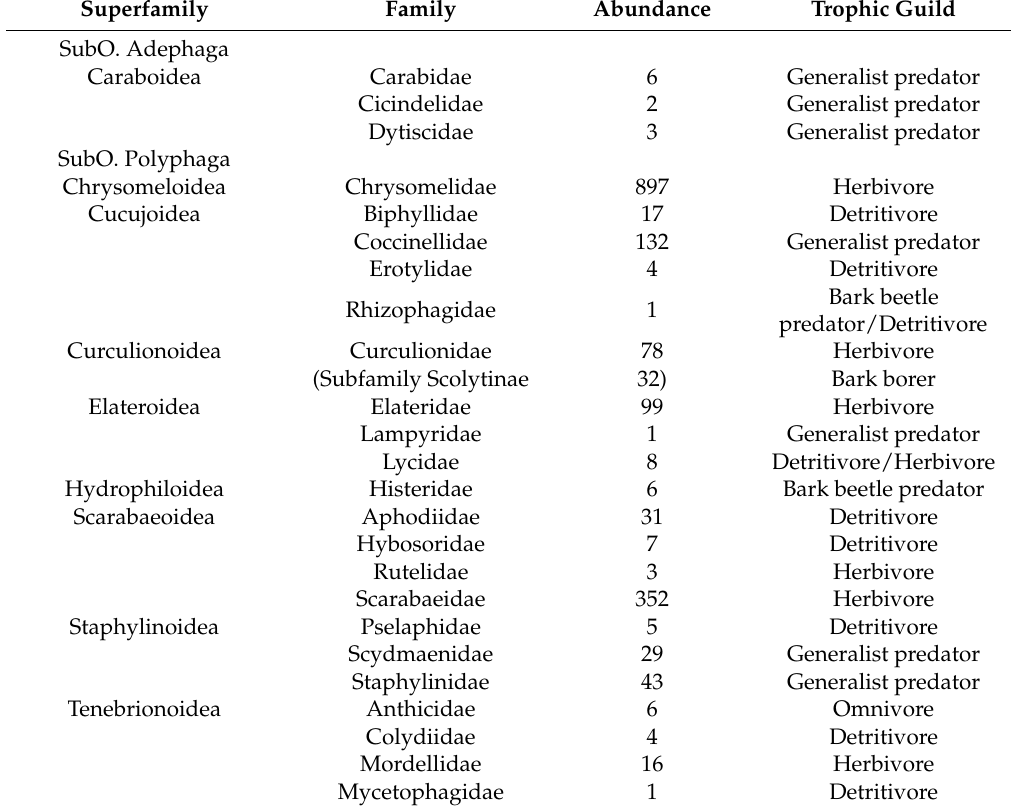
Table 3. Abundances of families of Coleoptera collected in all samples. Main trophic guilds of every family are included.